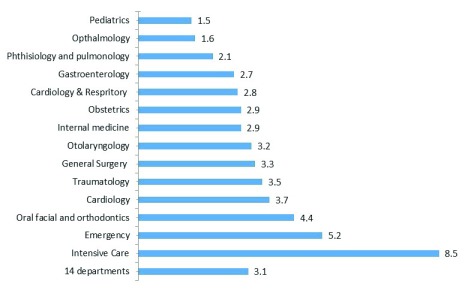
The average number of injections / patient / day by Department.